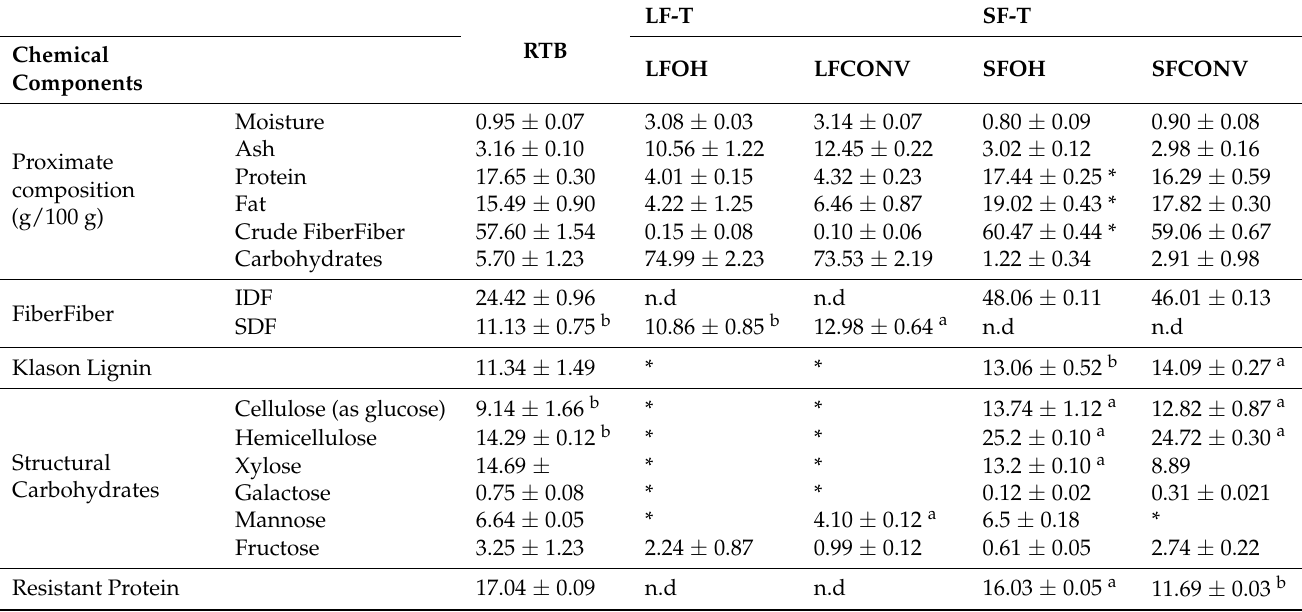
Table 5. Chemical composition of raw tomato bagasse (RTB) and tomato fractions (LF-T and SF-T) obtained after OH and CONV extractions (g/100 g